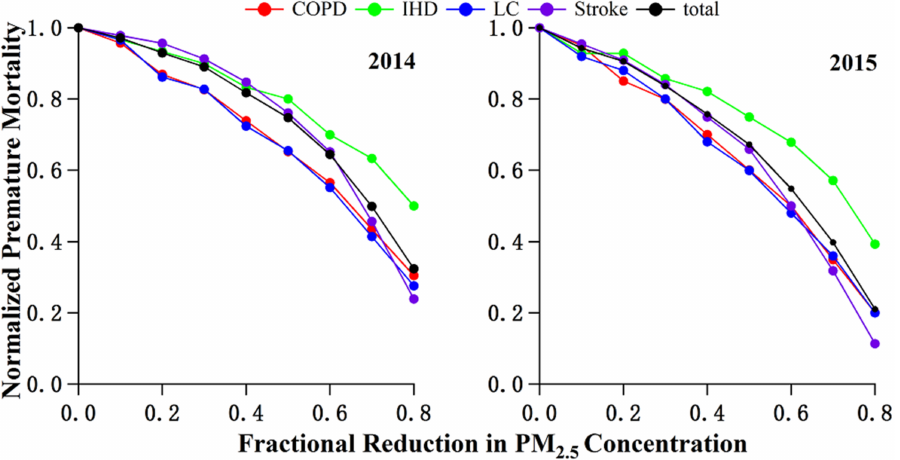
Figure 5. Normalized premature mortality as a function of fractional reduction in PM 2.5